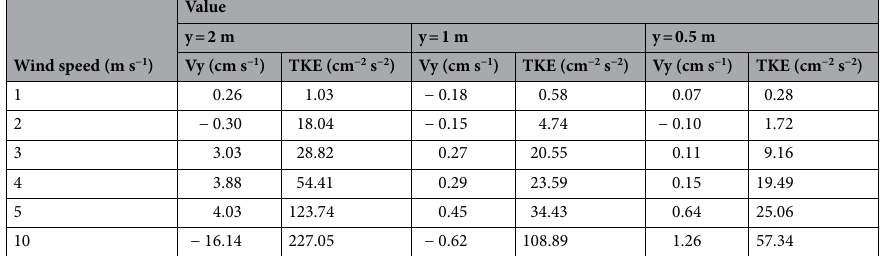
Table 1. Velocity and TKE of wind-driven currents at different depths.